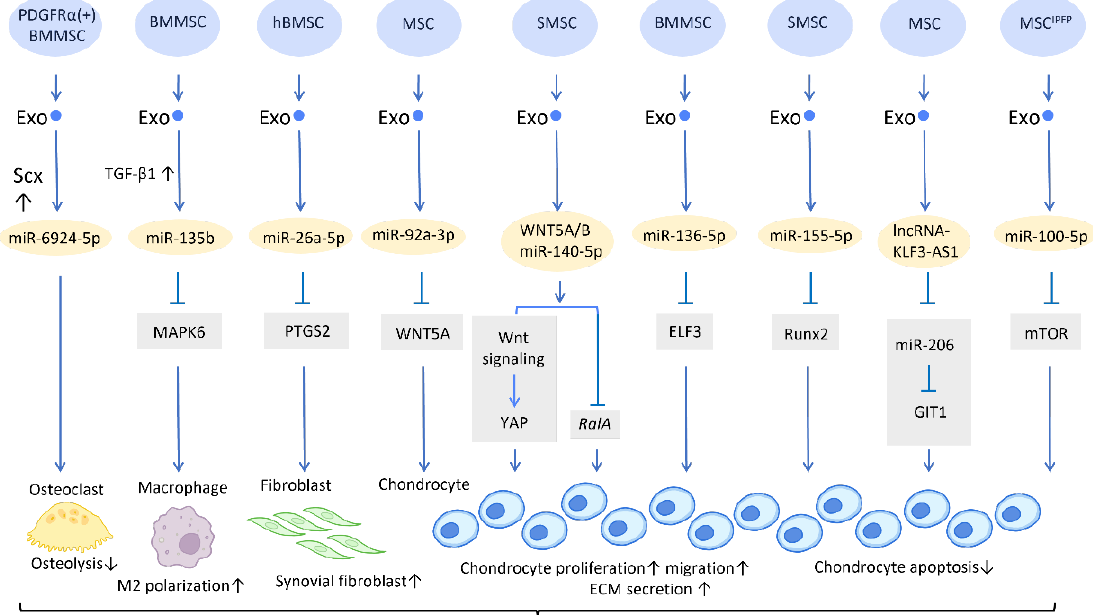
Figure 1. Molecular mechanisms of stem cell-derived exosomes in sport injuries and osteoarthritis. Stem cell-derived exosomes promote tissue healing, M2 polarization, fibroblast activation, chondro- cyte proliferation and migration, and decreases osteolysis and chondrocyte apoptosis via transferring of diverse molecular components. An overall regenerative effect was demonstrated, which manifested as improved musculoskeletal healing and osteoarthritis recovery. Abbreviation: Scx: scleraxis; PTGS2: prostaglandin-endoperoxide synthase 2; YAP: Yes-associated protein; ELF3: E74- like factor 3; GIT1: G-protein-coupled receptor kinase interacting protein-1; hBMSC: human bone MSC; SMSC: synovial MSC; MSC IPFP : infrapatellar fat pad. ↑ represents upregulation; ↓ represents down- regulation.